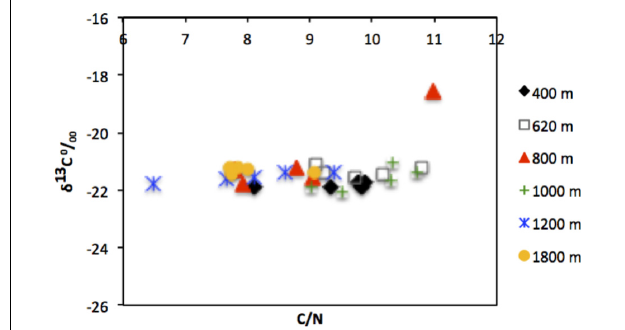
FIGURE 3 | Scatter plot showing relationship between C/N ratio and δ 13 Corg measured in surface sediments (0–10 cm) of the study sites off Costa Rica.